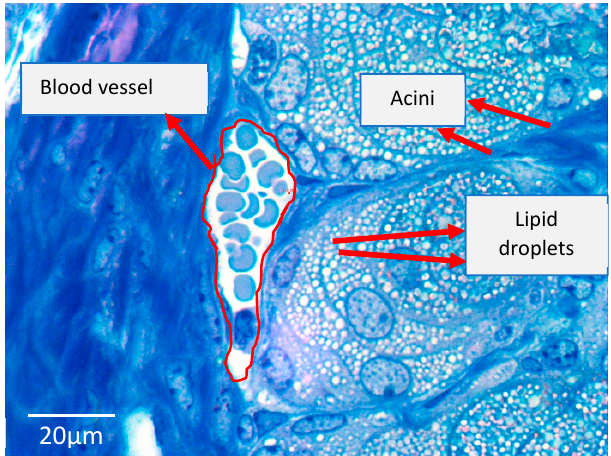
Figure 4. Light micrograph of an 8-week-old mouse meibomian gland stained with toluidine blue. A large blood vessel (red outline) containing erythrocytes is positioned close to the meibomian gland acini. Mag.100x .